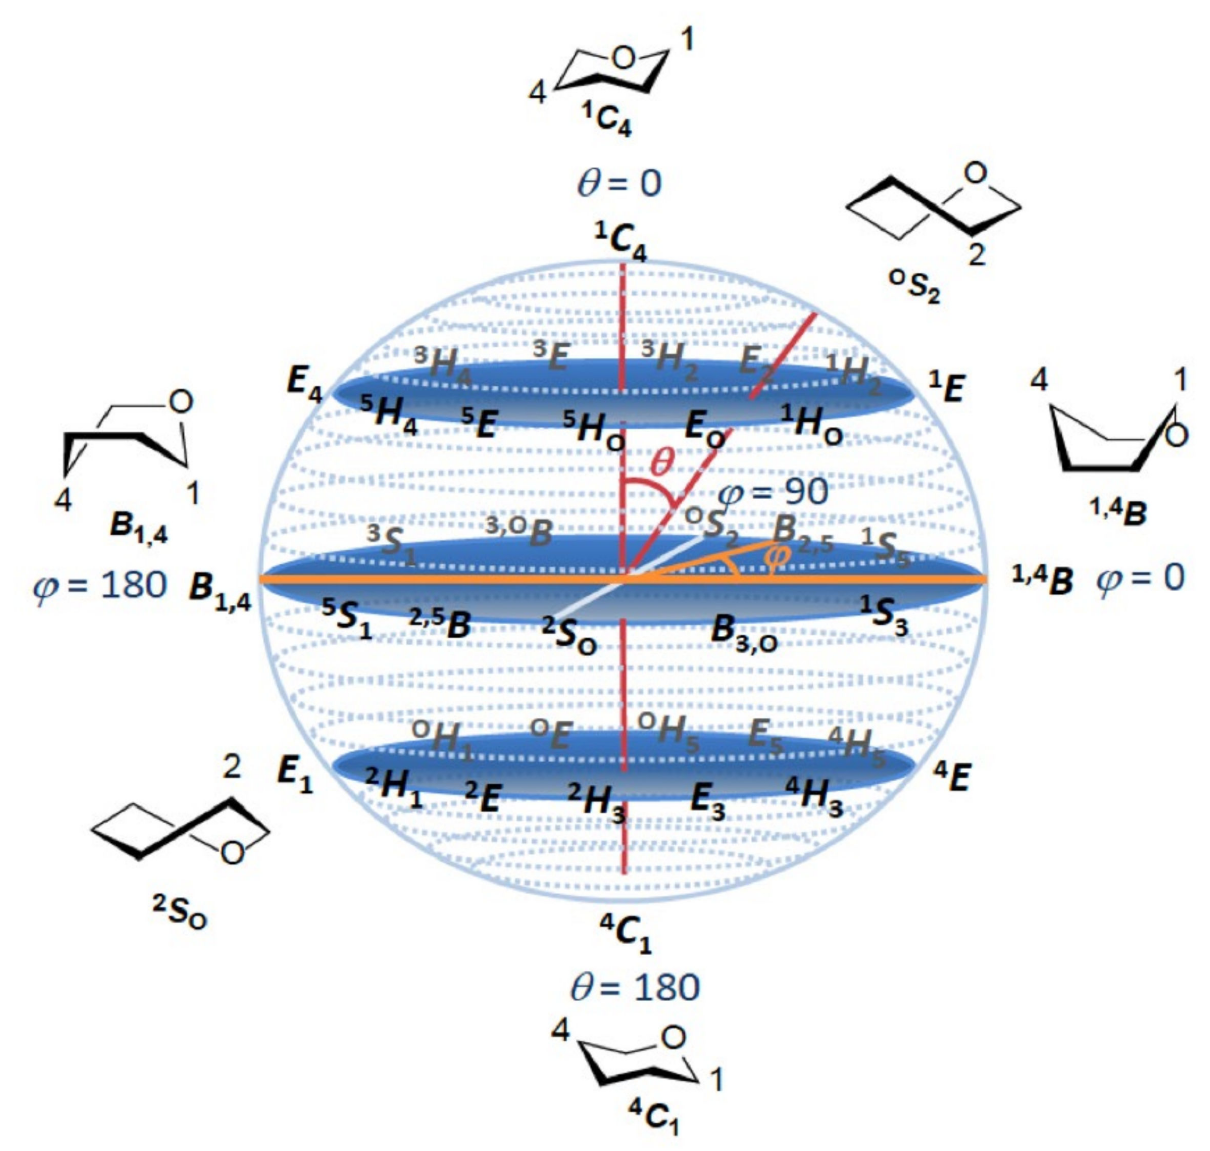
Figure 3. Cremer–Pople with 38 canonical